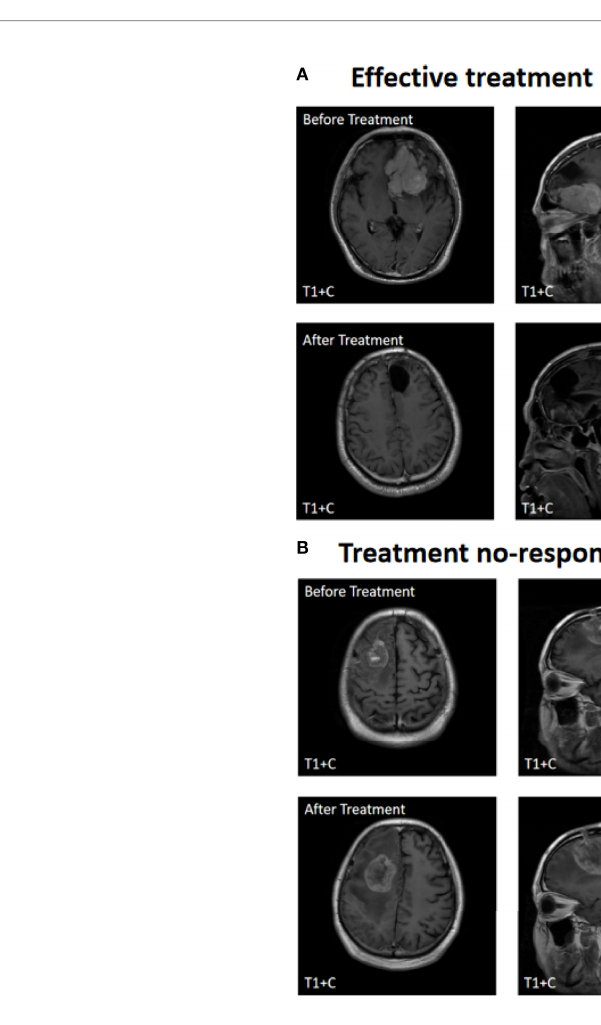
FIGURE 2 | Treatment response. (A) Effective treatment. (B) Treatment